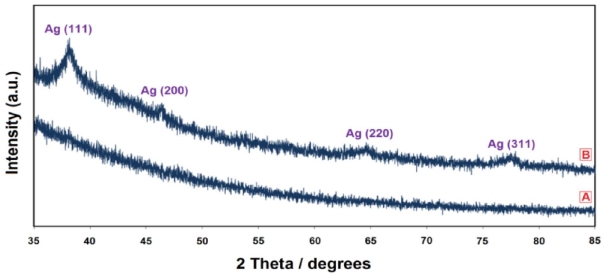
XRD patterns of gelatin/AgNO3 (A) and gelatin based Ag-NPs after UV irradiation for 24 h; (B) in gelatin solution (1%).